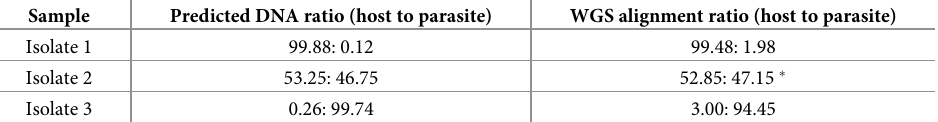
Table 2. qPCR predicted host-to-parasite DNA ratios, WGS read alignment percentages, and from three adult O . lupi nematodes. � Reported ratio is not based on total read